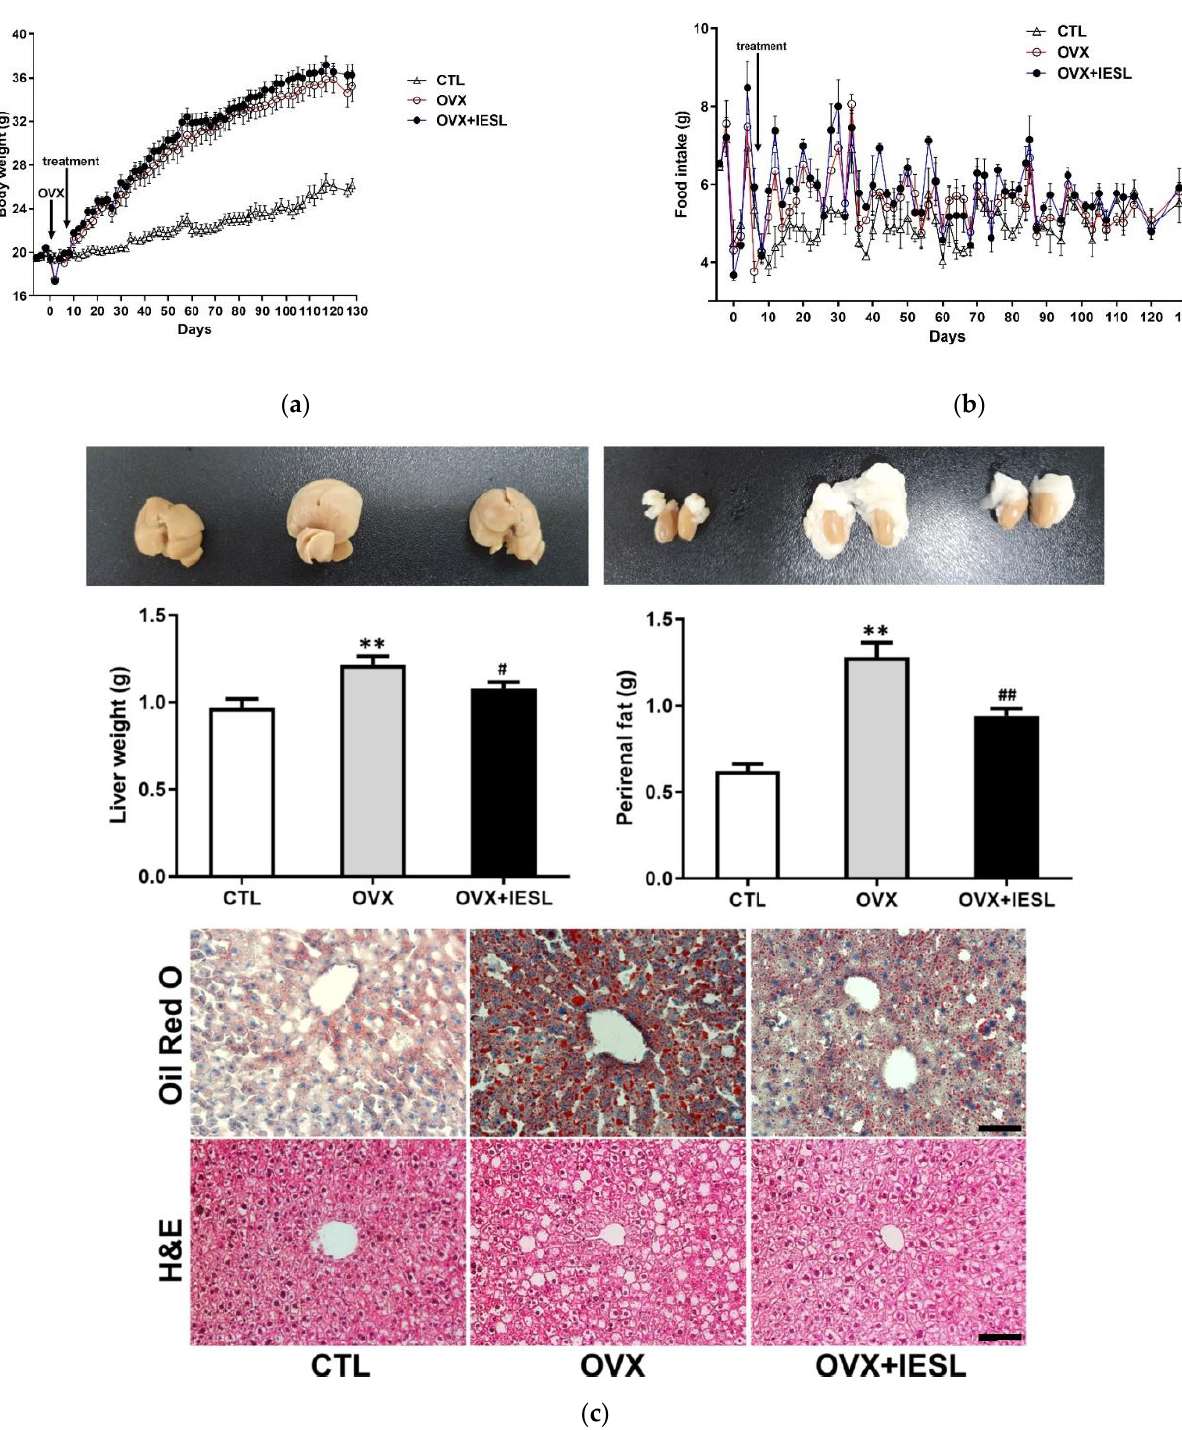
Figure 2. Establishment of the mouse ovariectomized (OVX) model and effects of the isoflavone- enriched soybean leave (IESL) extracts on the body weight, food intake, and fat accumulation in the control (CTL), OVX, OVX+IESL mouse groups. OVX increased the body weight significantly in the OVX and OVX+IESL groups compared to the CTL group ( a ), but there was no significant difference in food intake among the groups ( b ). In addition, OVX markedly increased the fat accumulation in the liver and perirenal tissues in the OVX+IESL group ( c ). However, administration of IESLs significantly decreased the fat accumulation compared with the OVX group. ** p < 0.01 vs. the CTL group; # p < 0.05 and ## p < 0.01 vs. the OVX group. Scale bars = 100 um.